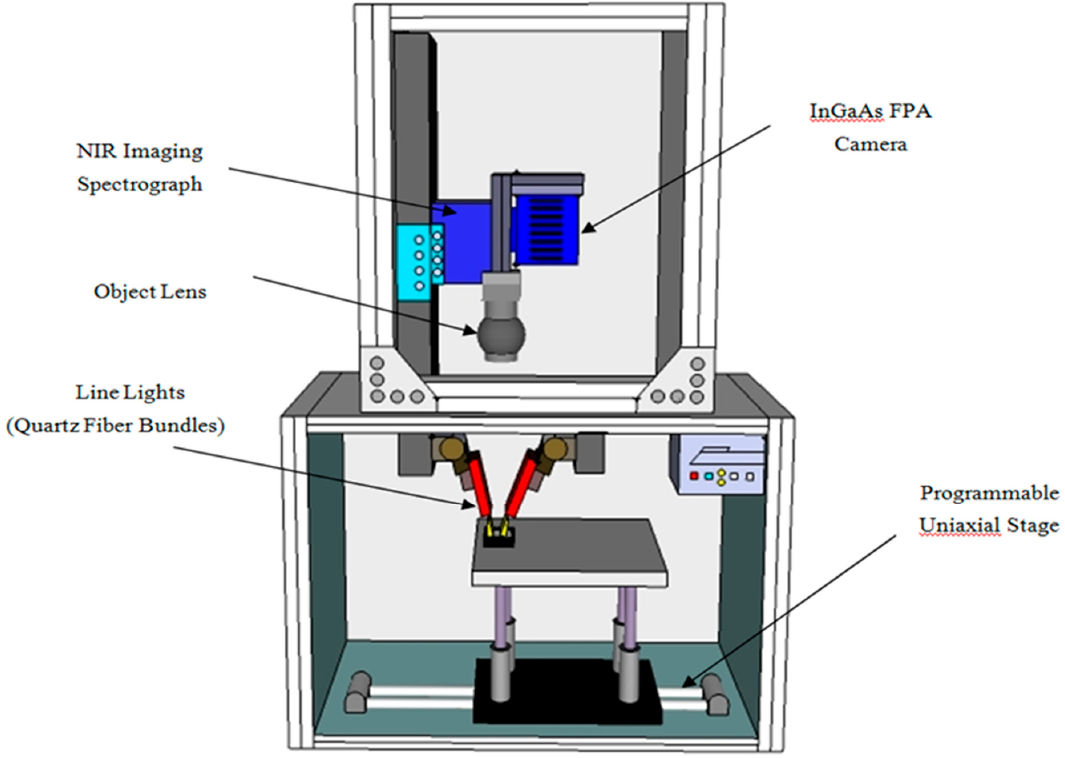
Figure 2. Schematic of the NIR hyperspectral imaging system used to acquire reflectance images of milk powders. FPA, focal-plane-array.